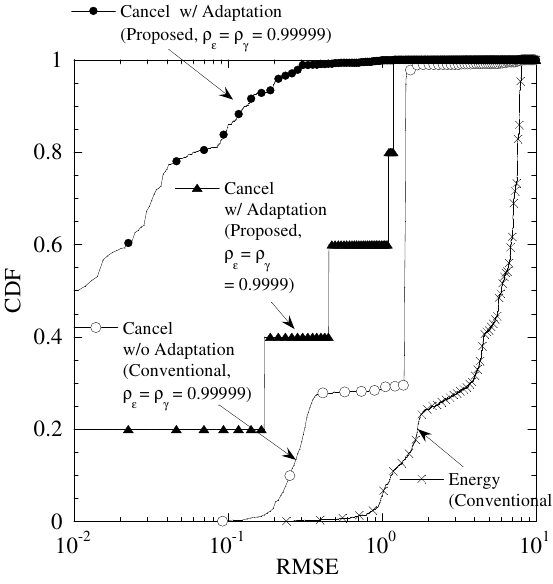
Figure 13. CDF of RMSE in temperature sensor of Part